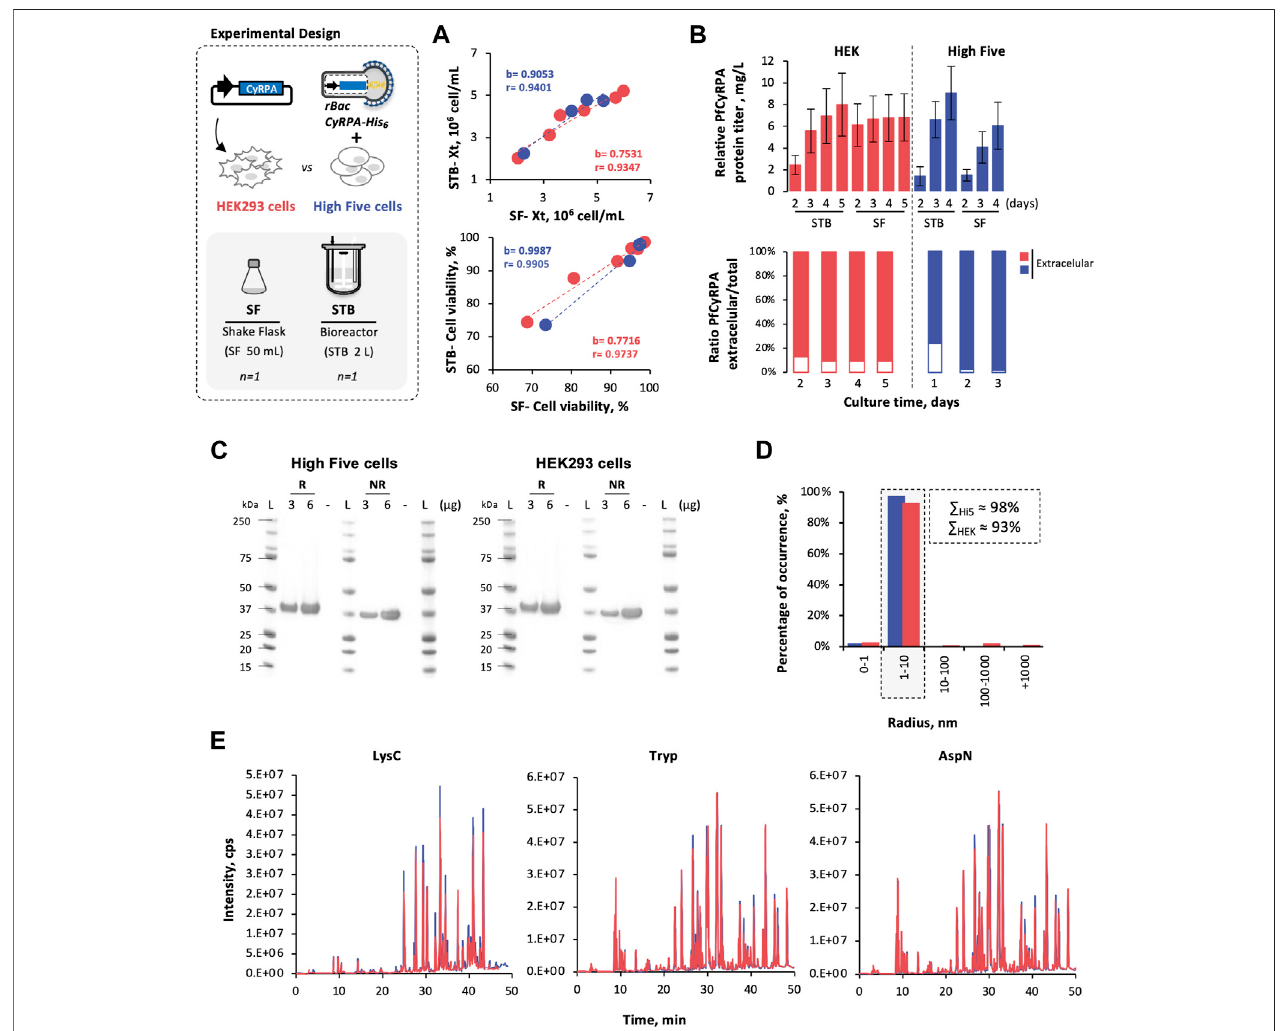
FIGURE 2 | Scale-up Pf CyRPA production in insect and mammalian cells. (A) Cell growth and viability kinetics obtained in STB and SF cultures. (B) Relative Pf CyRPA protein titer (mg/L) and the ratio of extracellular/total Pf CyRPA (%), obtained by densitometry analysis of Western blot images. (C) SDS-PAGE of puri fi ed Pf CyRPA, under reduced (R) and non-reduced (NR) conditions; Ladder (L) is SeeBlue ™ Plus2 Pre-stained Protein Standard. (D) Dynamic light scattering pro fi le of puri fi ed Pf CyRPA. (E) Peptideidenti fi cationofpuri fi ed Pf CyRPA,digestedwithLysC,trypsin,andAspN,byLC-MSusingX500BQTOF(ABSciex).Colorcode:High Five cells (blue) and HEK293 cells (red). Data in bar graphs are expressed as mean ± standard deviation (relative to three technical replicates, n = 3). Statistical signi fi cance was tested by t-test unpaired assuming Gaussian distribution.